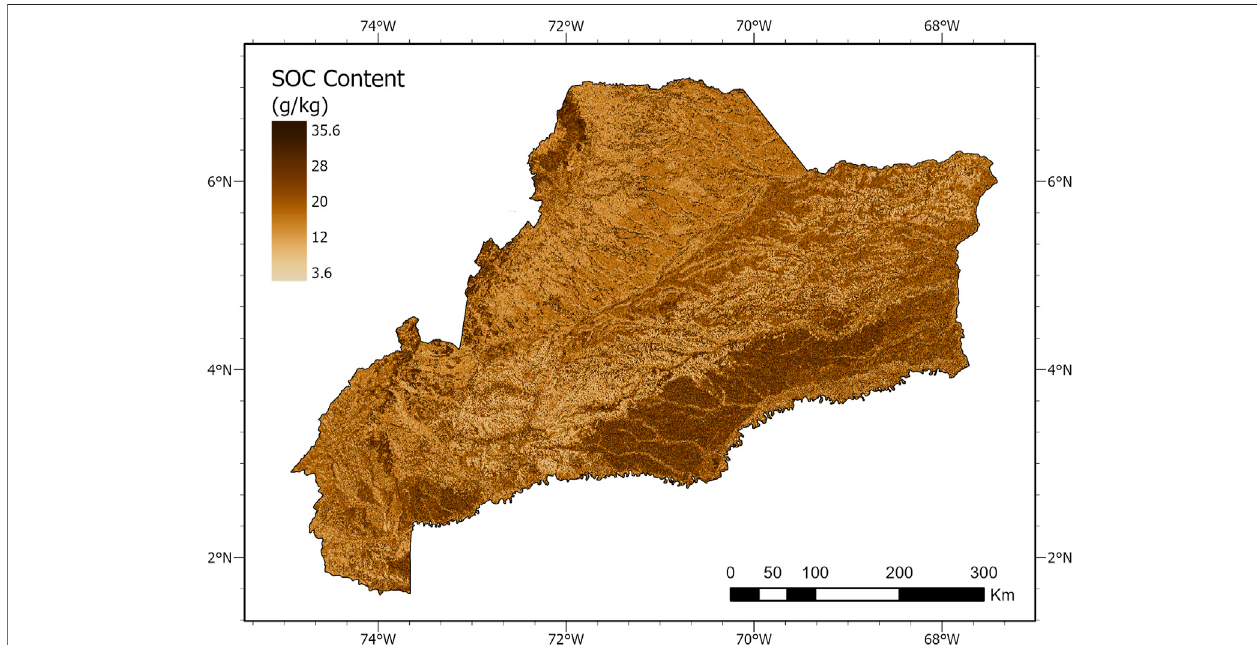
FIGURE 2 | Predicted SOC content (g kg − 1 ) in the Eastern Plains.